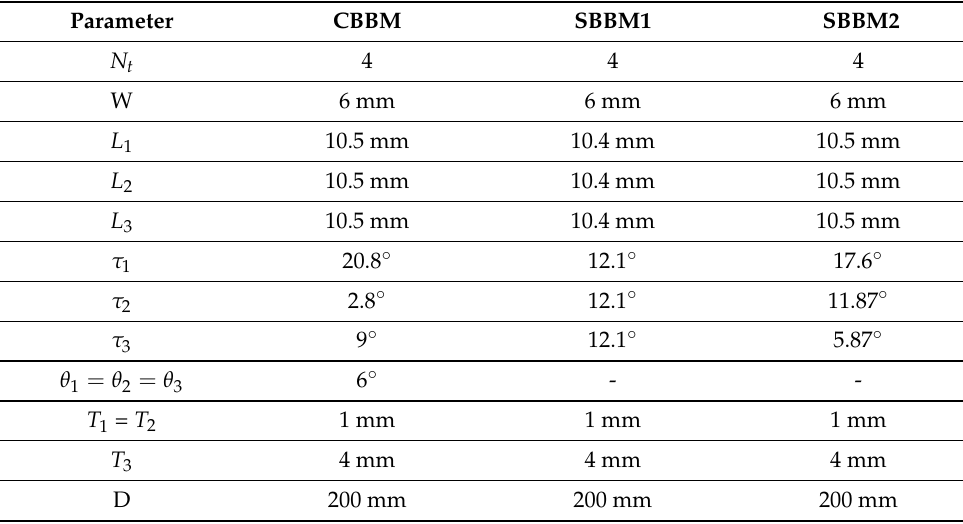
Figure 9. ( a ) Geometric parameters of SBBM1; ( b ) Geometric parameters of SBBM2. Table 1. Geometric parameters of evaluated bistable